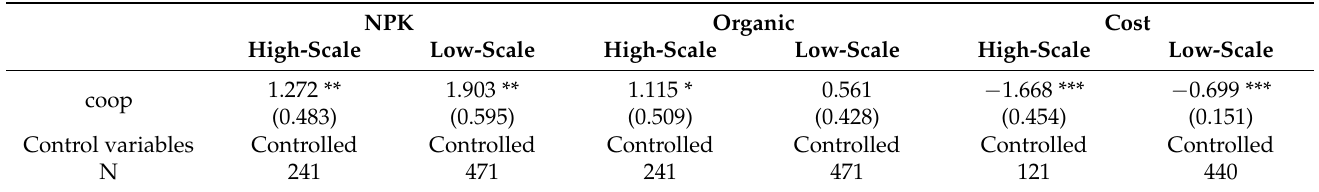
Table 5. Scale heterogeneity analysis of joining cooperatives on smallholder farmers to reduce fertilizer application.